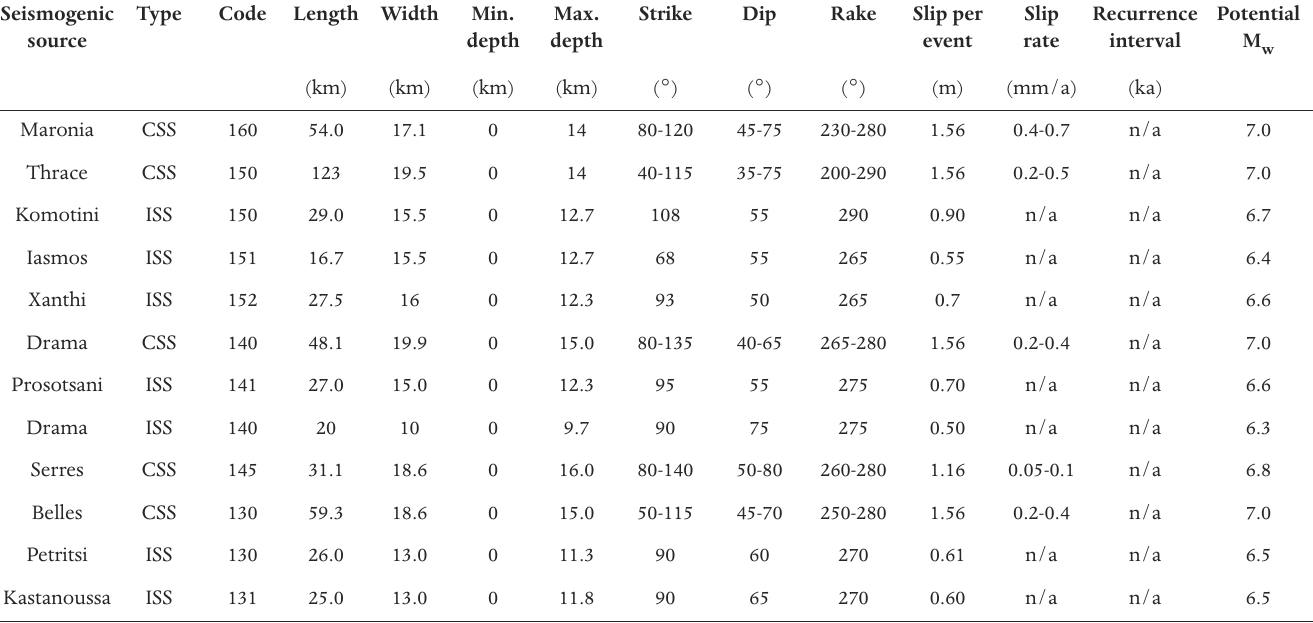
Table 2. Seismotectonic parameters of the CSSs and ISSs included in the Northern Belt (see Figure 3). CSS, composite seismogenic source; ISS, individual seismogenic source; Code, identification number within the database; n/a, not